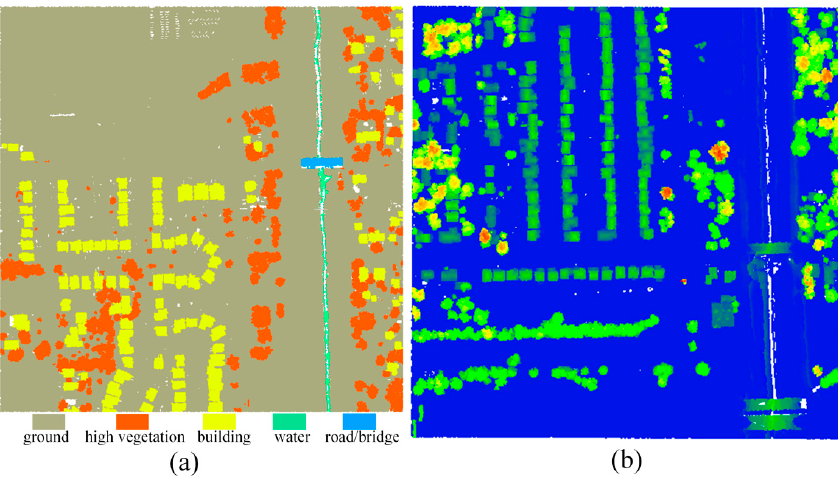
Figure 8. The dataset derived from the 2019 IEEE GRSS Data Fusion Competition: ( a ) training dataset displayed by label, ( b ) testing dataset displayed by the normalized height.